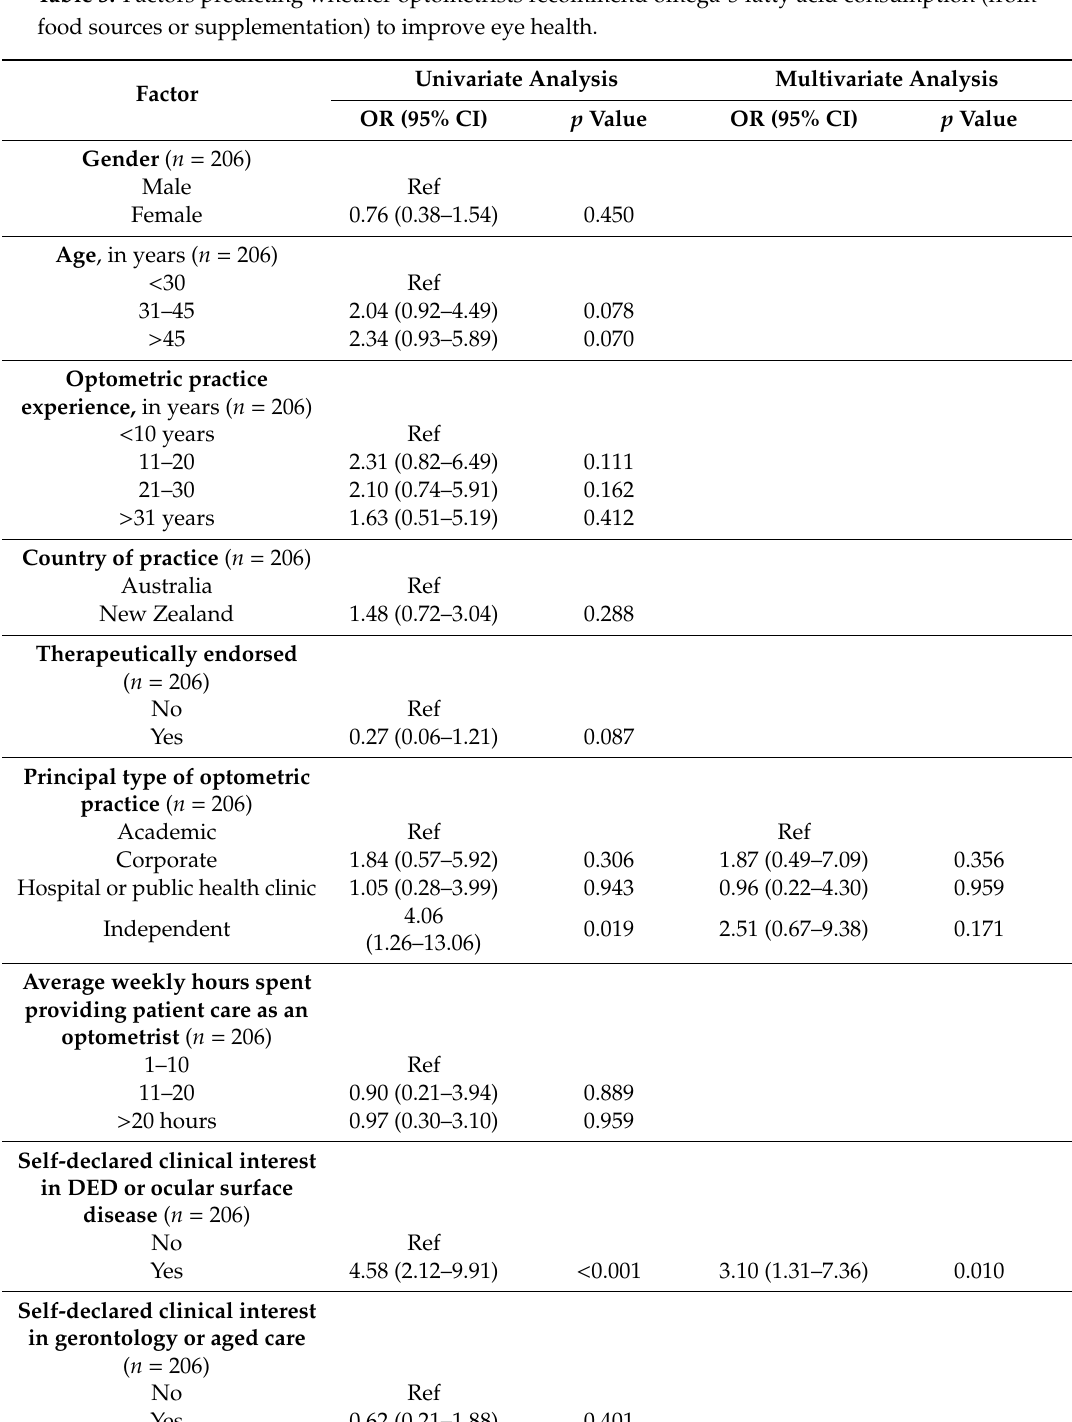
Table 3. Factors predicting whether optometrists recommend omega-3 fatty acid consumption (from food sources or supplementation) to improve eye